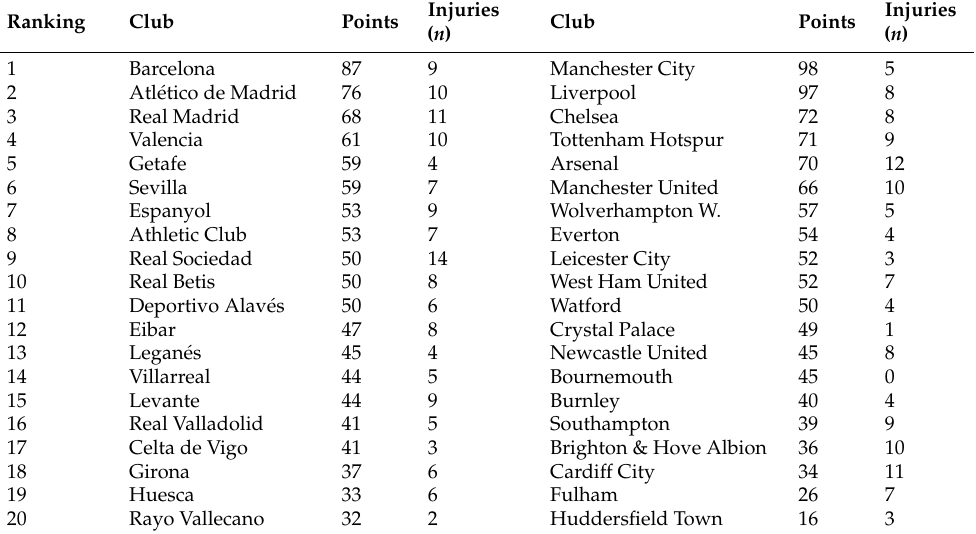
Table 3. Analysis of injuries by club.